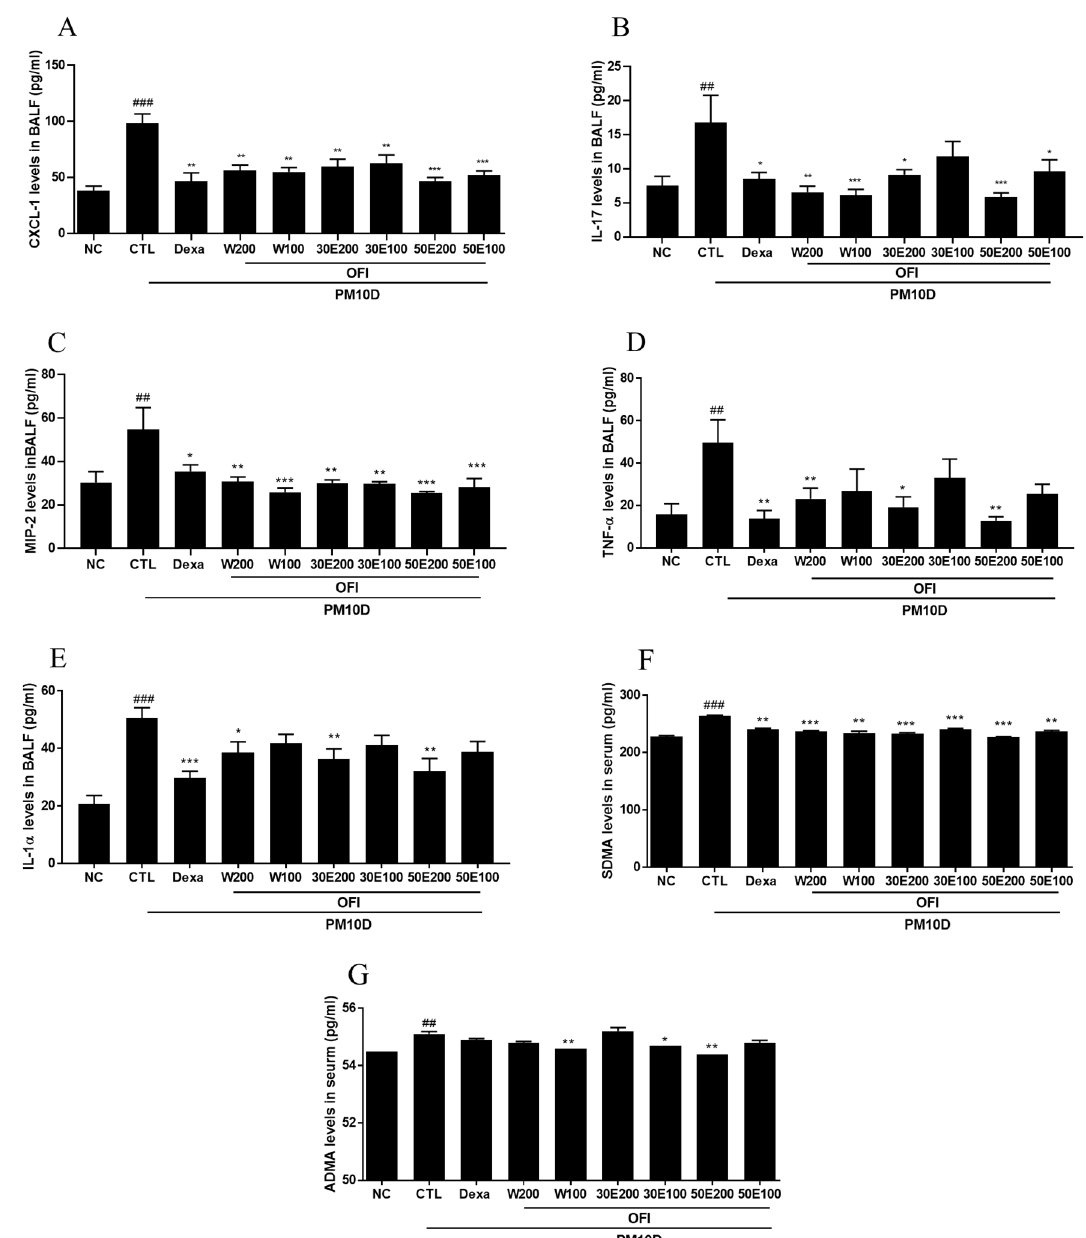
Figure 3. Effects of water and ethanolic extracts of OFI on pro-inflammatory cytokines in BALF and serum in a PM10D-induced airway inflammation model. ( A ) Chemokine (C-X-C motif) ligand 1 (CXCL-1), ( B ) interleukin (IL)-17, ( C ) macrophage inflammatory protein (MIP)-2, ( D ) tumor necrosis factor (TNF)- α , ( E ) IL-1 α in BALF, ( F ) symmetric dimethyl arginine (SDMA), and ( G ) asymmetric dimethyl arginine (ADMA) concentrations in serum. NC: BALB/c normal control group; CTL: PM10D-induced control group; Dexa: 3 mg/kg dexamethasone-treated PM10D-induced group; OFI-W 100 and 200: PM10D-induced group treated with 100 and 200 mg/kg OFI-water extract, respectively; OFI-30E 100 and 200: PM10D-induced group treated with 100 and 200 mg/kg OFI-30% ethanol extract, respectively; OFI-50E 100 and 200: PM10D-induced group treated with 100 and 200 mg/kg OFI-50% ethanol extract, respectively. Data are expressed as means ± SEM, n = 8. ## p < 0.01 and ### p < 0.005 vs. NC; * p < 0.05, ** p < 0.01, and *** p < 0.005 vs. CTL.